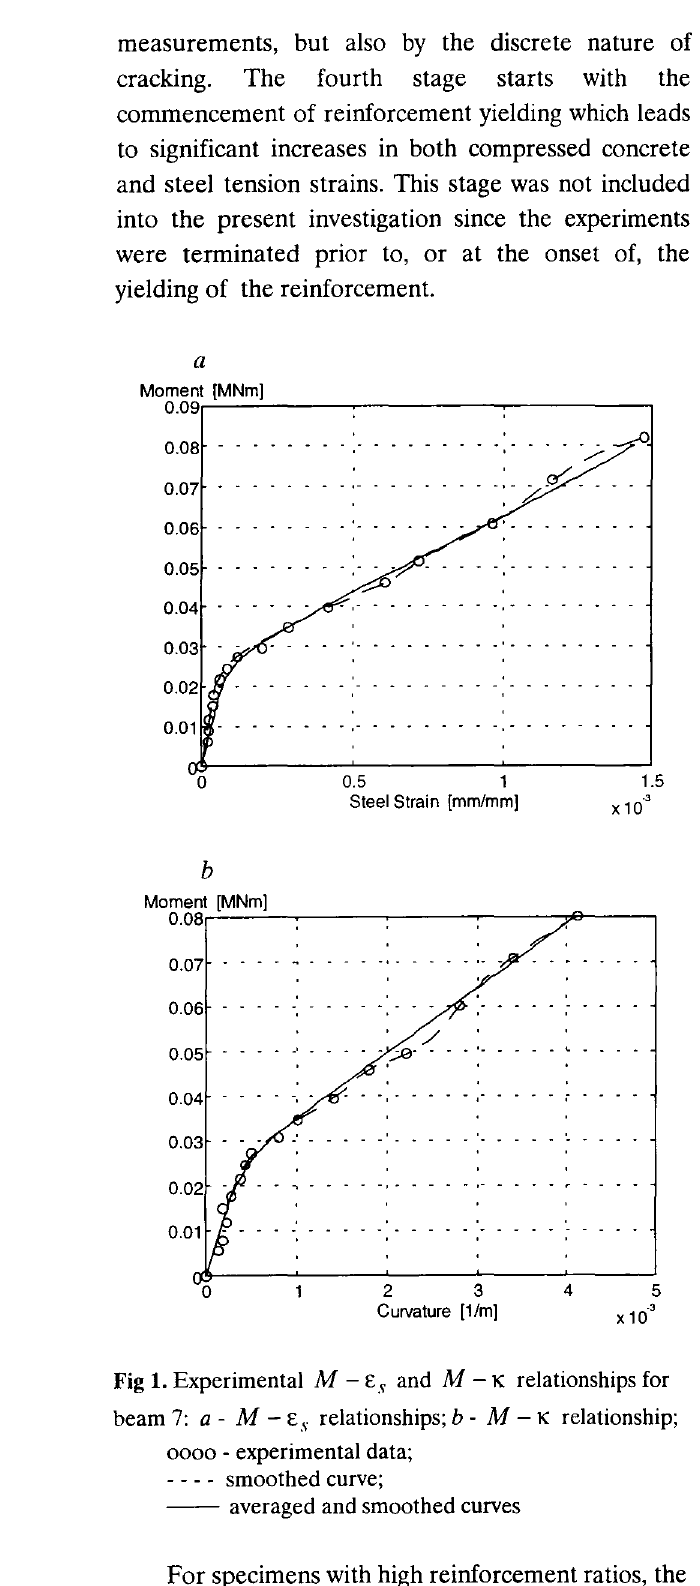
Fig 1. Experimental M - E.~ and M - K relationships for beam 7: a - M - E 1. relationships; b - M - K relationship; oooo - experimental data; - - - - smoothed curve; - - averaged and smoothed